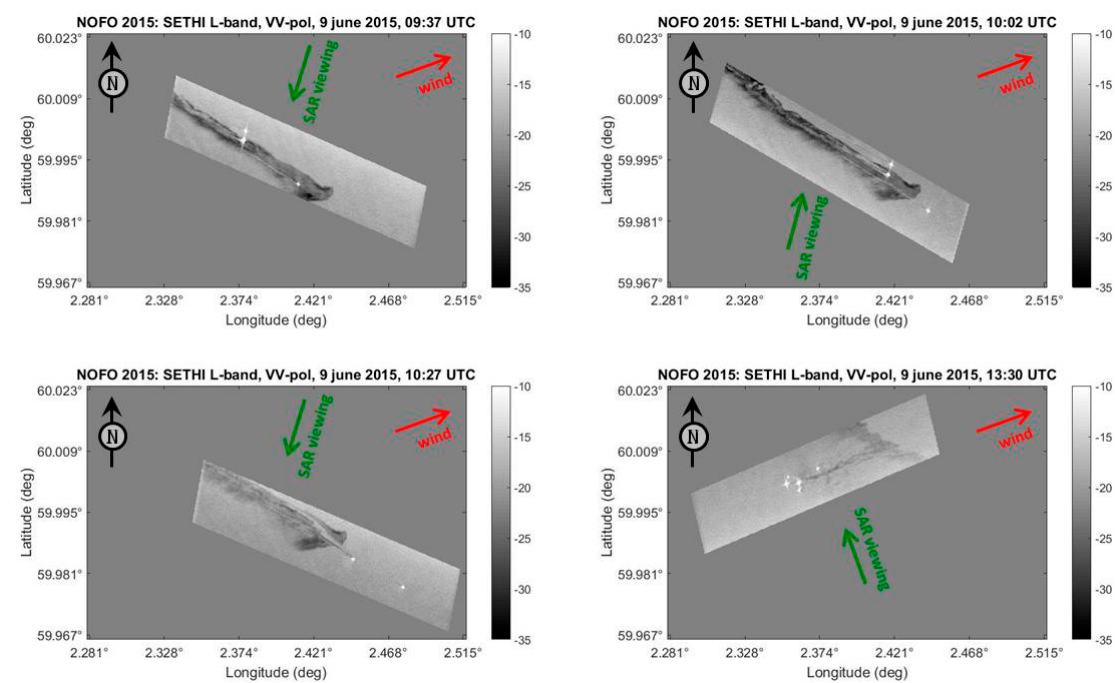
Figure 6. SETHI L-band SAR data, VV-polarization, collected at 09:37 UTC (run 1—upper left panel), 10:02 UTC (run 2—upper right panel), 10:27 UTC (run 3—lower left panel) and 13:30 UTC (run 4—lower right panel)—multi-look 21 × 21—ground geometry. Remote Sens. 2018 , 10 , x FOR PEER REVIEW